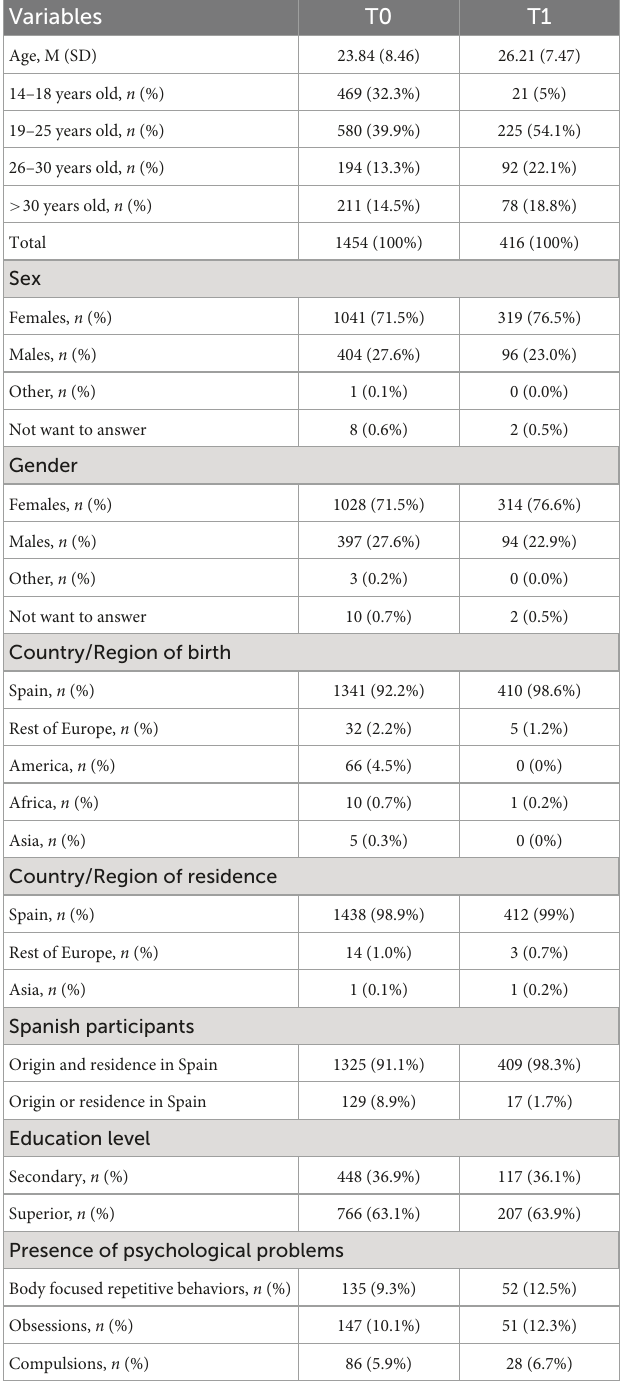
TABLE 1 Sociodemographic characteristics of the